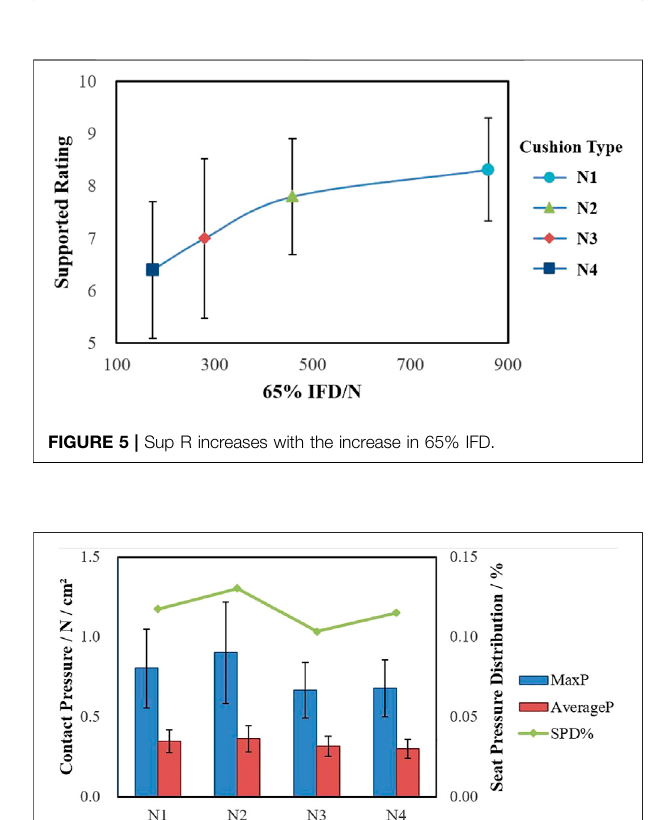
FIGURE 4 | The subjective rating is signi fi cantly different for the four types of cushions ( p (cid:1) 0.001) (* p < 0.05; ** p < 0.01).